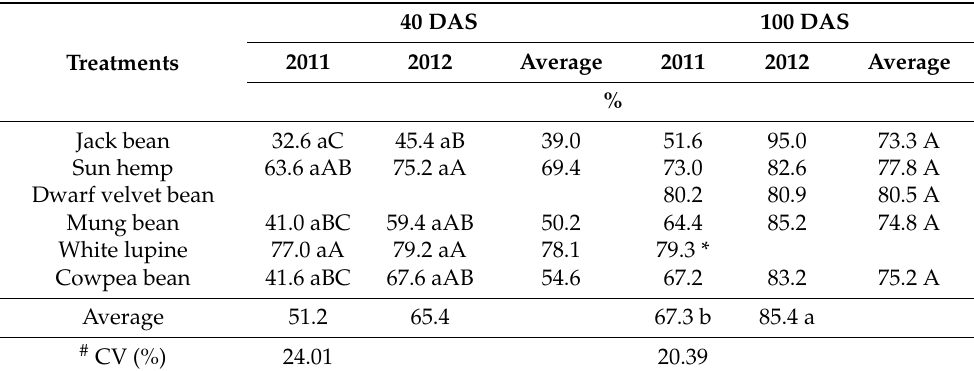
Table 5. Biological nitrogen fixation of legumes at 40 days after sowing (DAS) and 100 DAS in intercrop with cherry